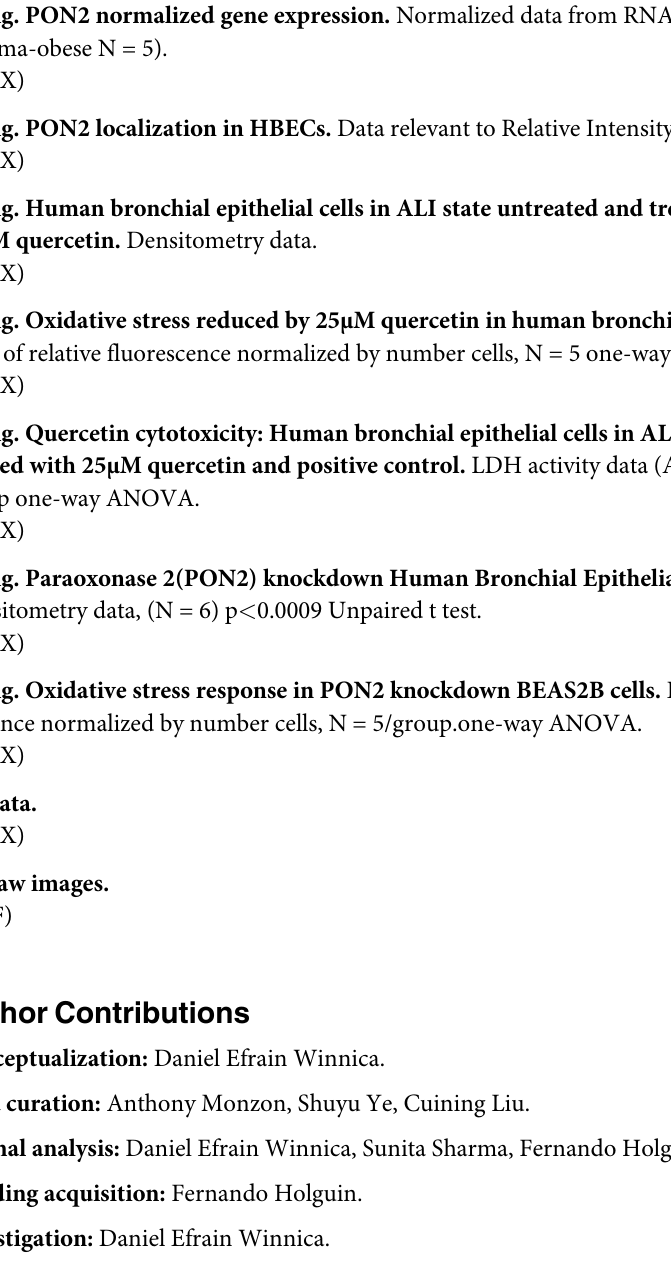
S1 Fig. PON2 protein levels in human bronchial epithelial cells. Data relevant to densitome- try of PON2 � p < 0.05, N = 4/group one-way ANOVA. (XLSX) S2 Fig. PON2 normalized gene expression. Normalized data from RNAseq (Lean N = 4; Asthma-obese N = 5). S3 Fig. PON2 localization in HBECs. Data relevant to Relative Intensity of PON2 expression. (XLSX) S4 Fig. Human bronchial epithelial cells in ALI state untreated and treated with 25 μ M and 50 μ M quercetin. Densitometry data. S5 Fig. Oxidative stress reduced by 25 μ M quercetin in human bronchial epithelial cells. Data of relative fluorescence normalized by number cells, N = 5 one-way ANOVA. (XLSX) S6 Fig. Quercetin cytotoxicity: Human bronchial epithelial cells in ALI state untreated, treated with 25 μ M quercetin and positive control. LDH activity data (Abs 490nm), N = 9/ group one-way ANOVA. S7 Fig. Paraoxonase 2(PON2) knockdown Human Bronchial Epithelial cells (BEAS-2B). Densitometry data, (N = 6) p < 0.0009 Unpaired t test. (XLSX) S8 Fig. Oxidative stress response in PON2 knockdown BEAS2B cells. Data of relative fluo- rescence normalized by number cells, N = 5/group.one-way